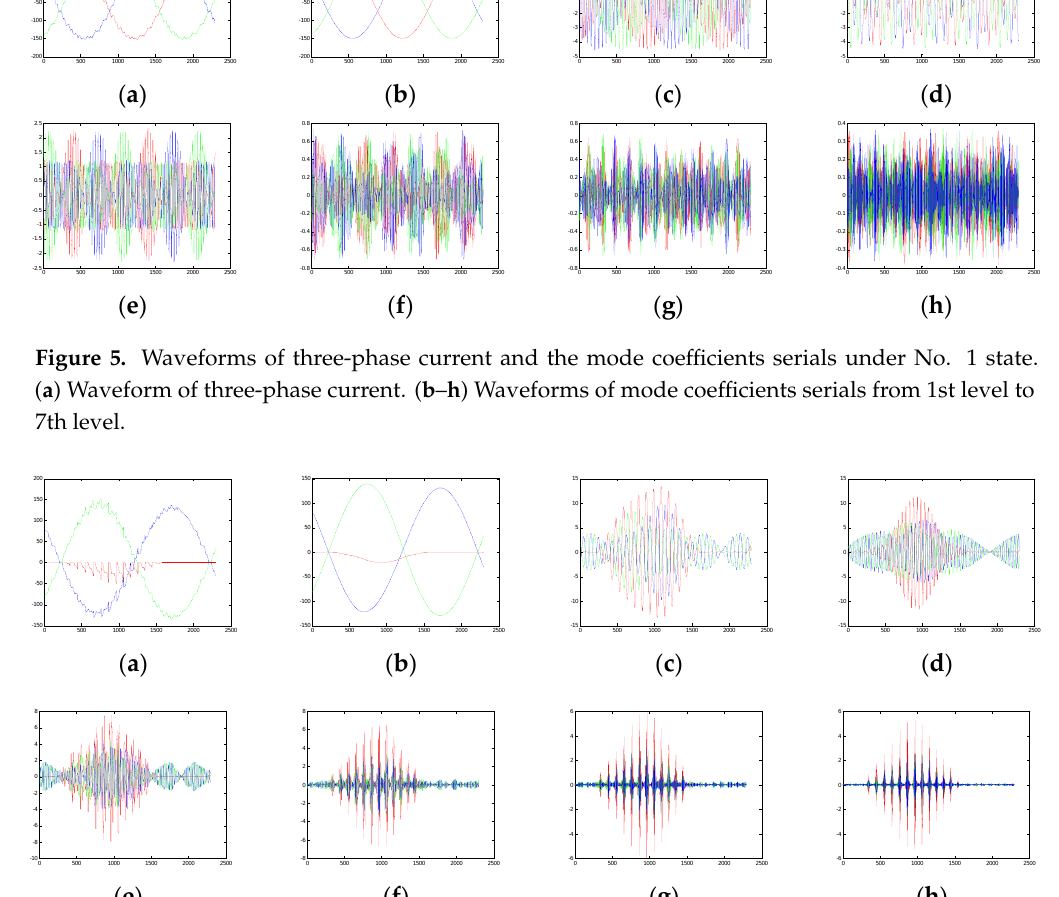
Table 3. The trend feature vectors under 22 states of GSC.